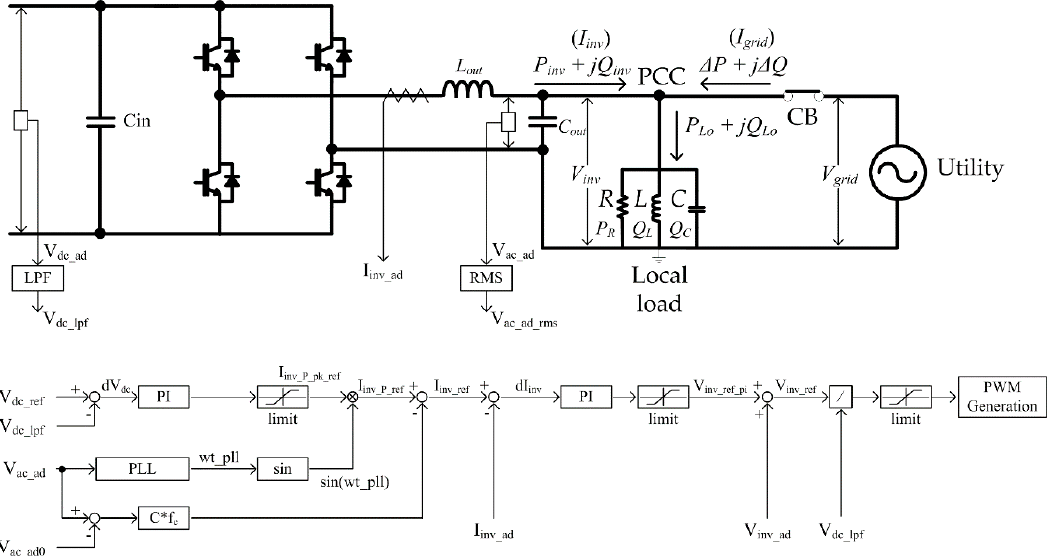
Figure 6. Simulation circuit for islanding test.